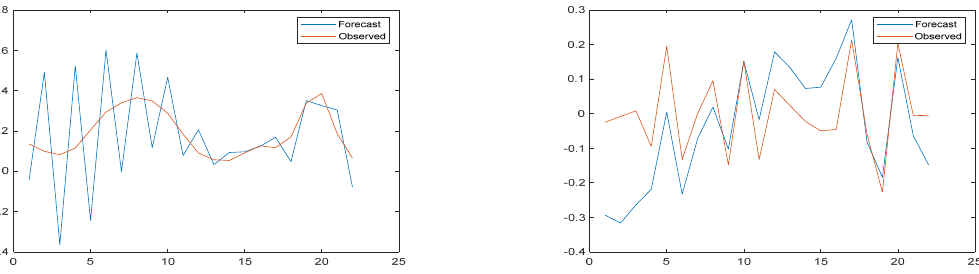
Figure 10. Prediction results and error images of the ANN-WT-LSTM model for high-frequency and low-frequency parts of the CODMN verification set.